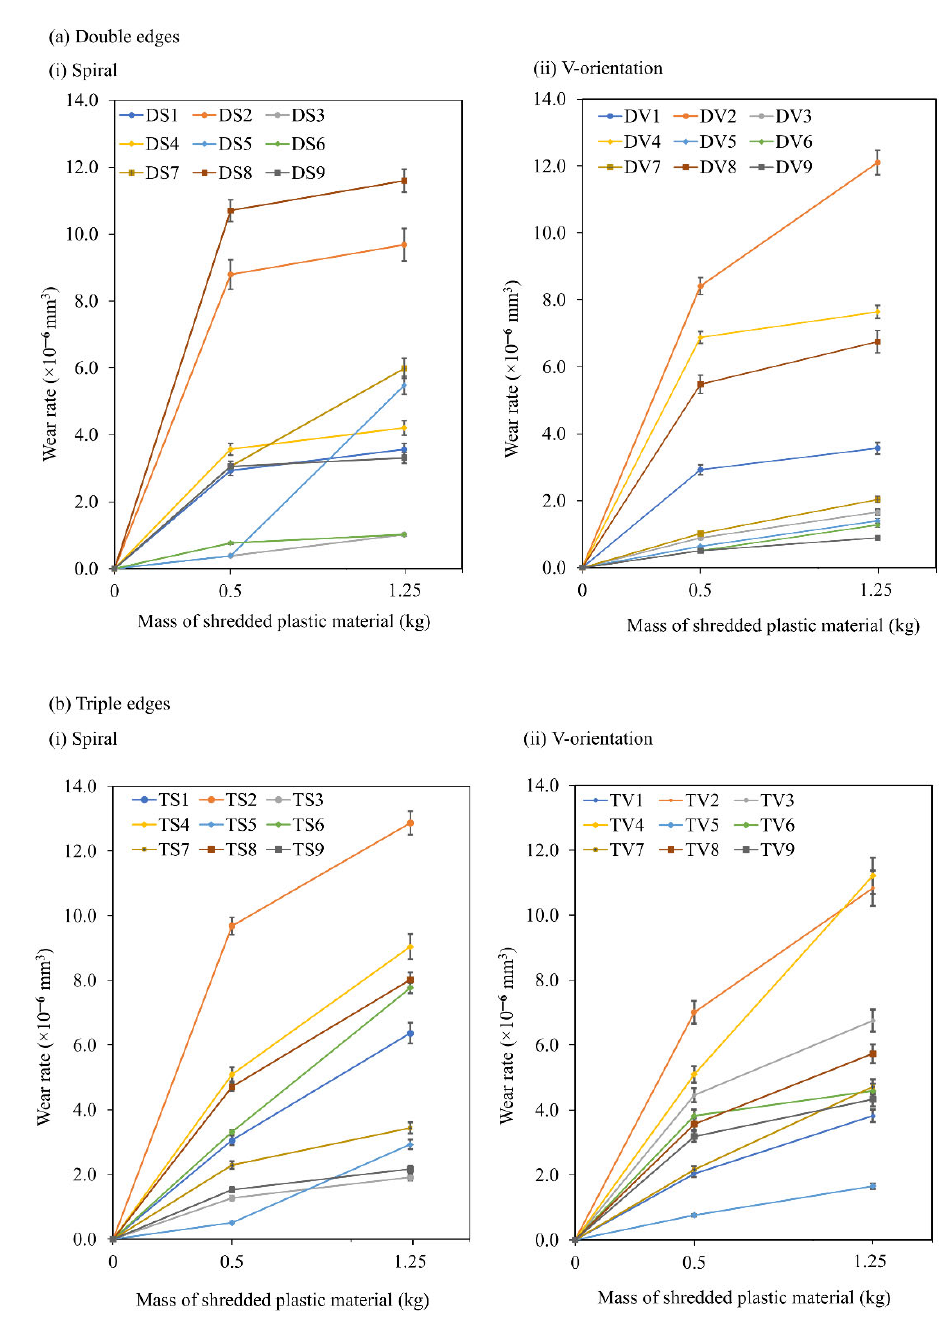
Figure 8. Wear rate of ( a ) double and ( b ) triple ‐ edge blade’s material after shredding of PET plastic in ( i ) spiral and ( ii ) V ‐